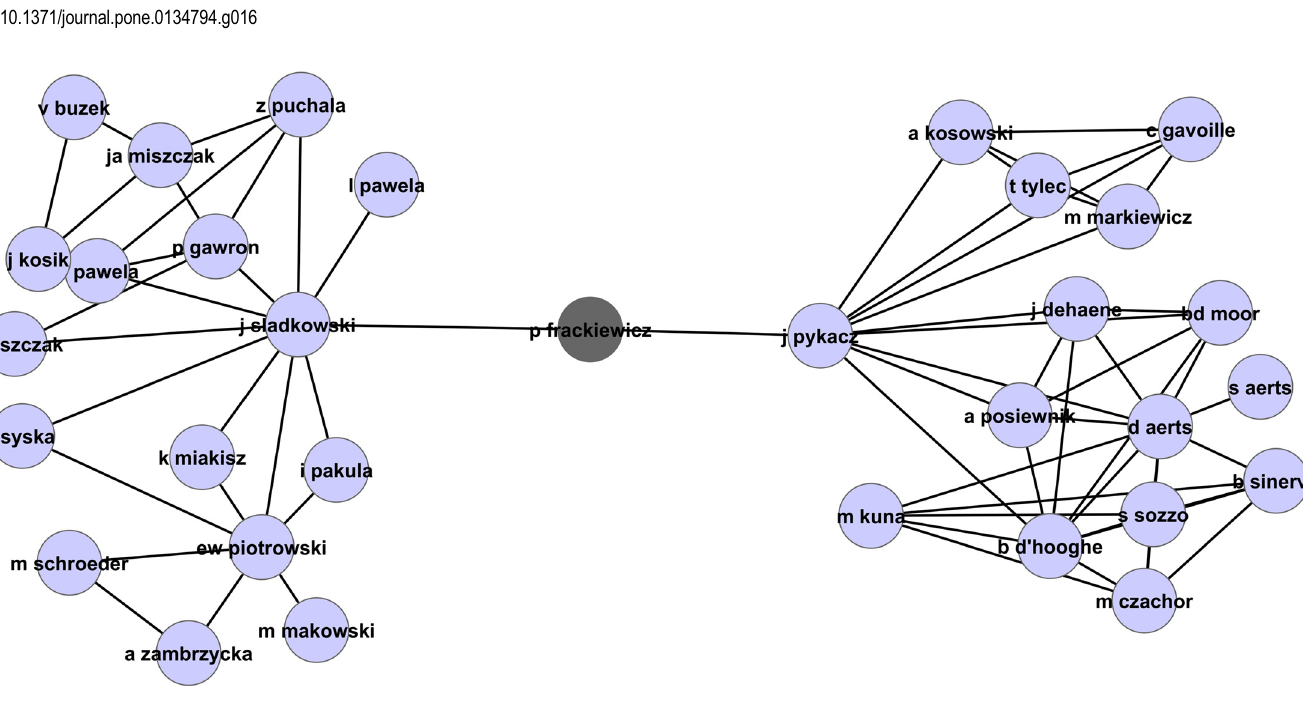
Fig 17. Part of the collaboration network highlighting P. Frackiewics (h-index:1 (h-index percentile 55.5%),pagerank-index:98.4%). It is clear that this author plays an important role in the field by being the ‘ bridge ’ between two sets of authors who work perhaps in two sub-fields. Note that though the collaboration network is not an input in computing the pagerank-index, the pagerank-index is able to recognize and reward authors who perform such an important role in the development of the field, as indicated by the relatively high pagerank-index of this author. The h-index, being a relatively simplistic citation count measure, fails to recognize this